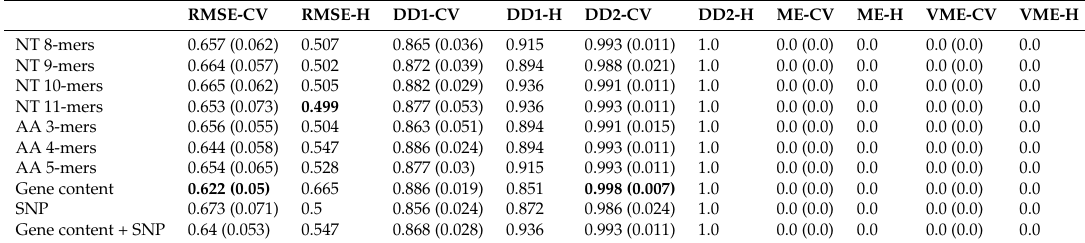
Table A14. C. jejuni